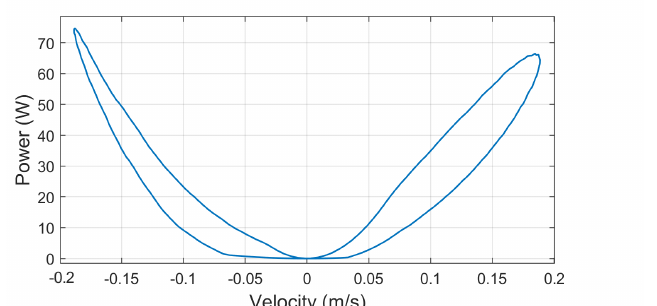
Figure 8. Power dissipated on the external resistor depending in the ball-screw damper’s